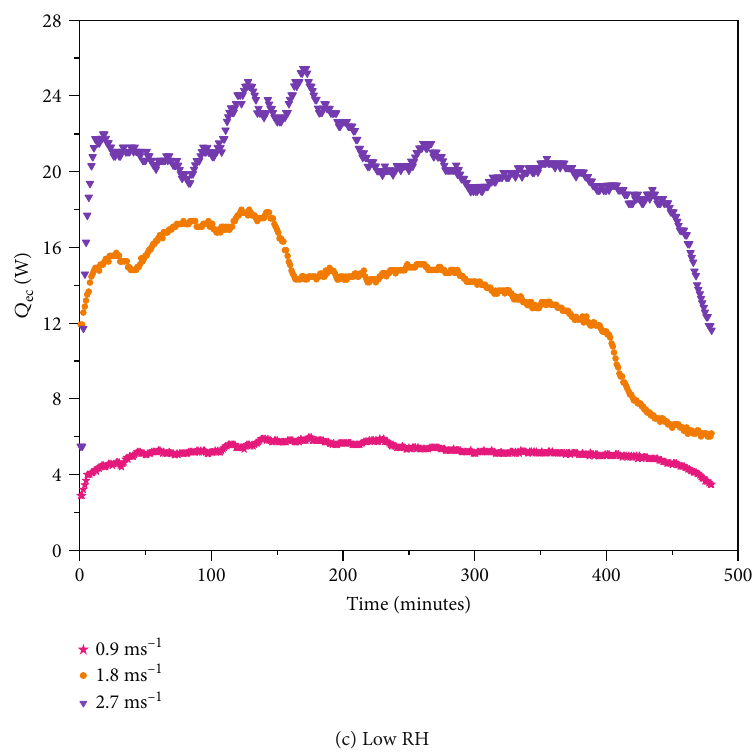
Figure 11: Instantaneous cooling capacity of the air cooler at three di ff erent velocities under three di ff erent RH conditions.